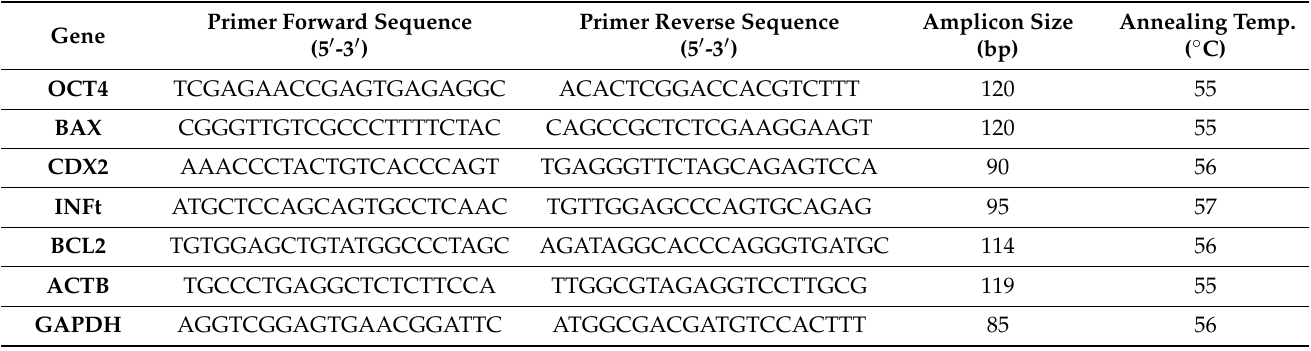
Table 1. Primers used for PCR and sequencing in the present